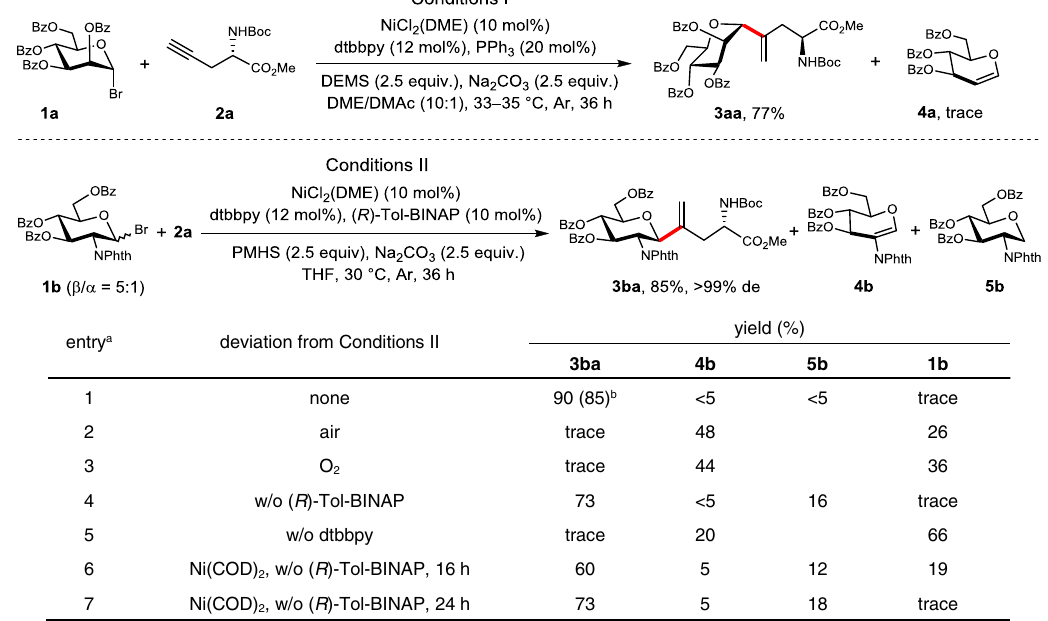
Fig. 2 Optimized reaction conditions I and II and the control experiments for Conditions II. a Reaction conditions: 1b (0.1 mmol), 2a (2.0 equiv.), NiCl 2 (DME) (10 mol%), dtbbpy (12 mol%), ( R )-Tol-BINAP (10 mol%), PMHS (2.5 equiv.), Na 2 CO 3 (2.5 equiv.), THF (1 mL), 30 °C, Ar, 36 h. The yields were determined by 1 H NMR using CH 2 Br 2 as an internal standard. b Isolated yield. DME dimethoxyethane, DEMS diethoxymethylsilane, DMAc N , N - dimethylacetamide, dtbbpy 4,4 ′ -di- tert -butyl-2,2 ′ -bipyridine, PMHS poly(methylhydrosiloxane), Tol-BINAP 2,2 ′ -bis(di- p -tolylphosphino)-1,1 ′ -binaphthyl, w/o without. In red are the formed C -glycosidic